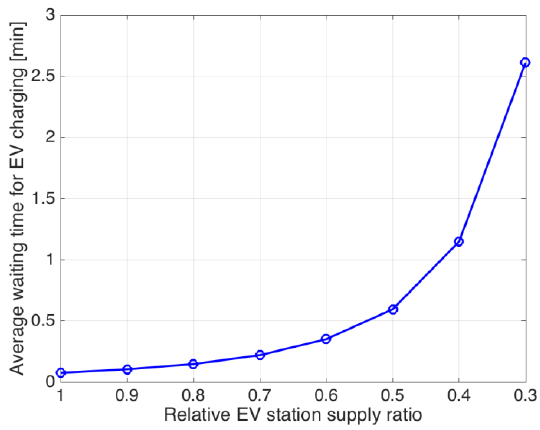
Figure 10. Average waiting time for EV charging according to the relative EV supply ratio.